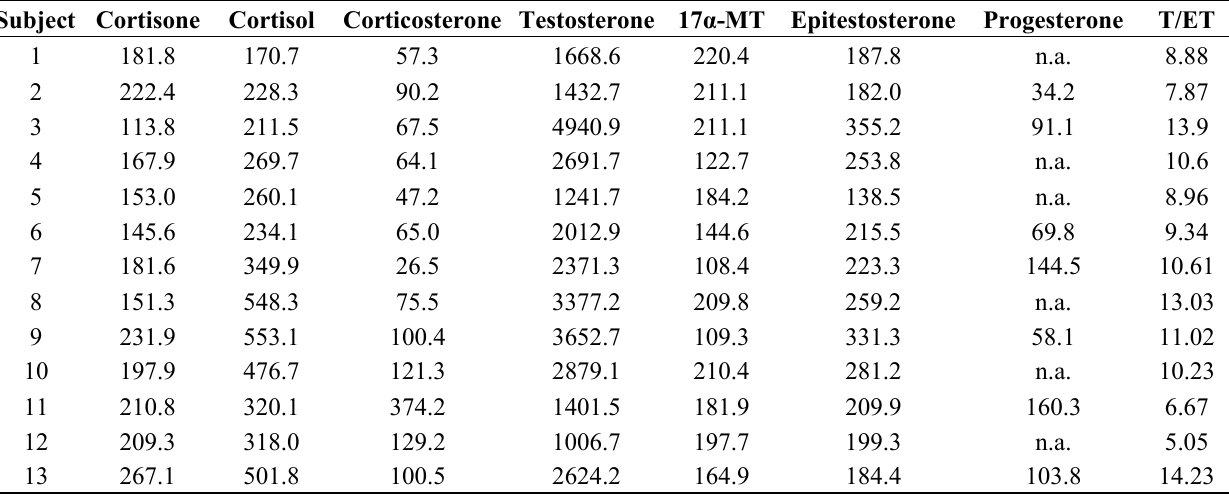
Table 4. The values of concentrations of steroid hormones (in ng mL − 1 ) identified in urine samples of amateur weight-lifters using hormonal